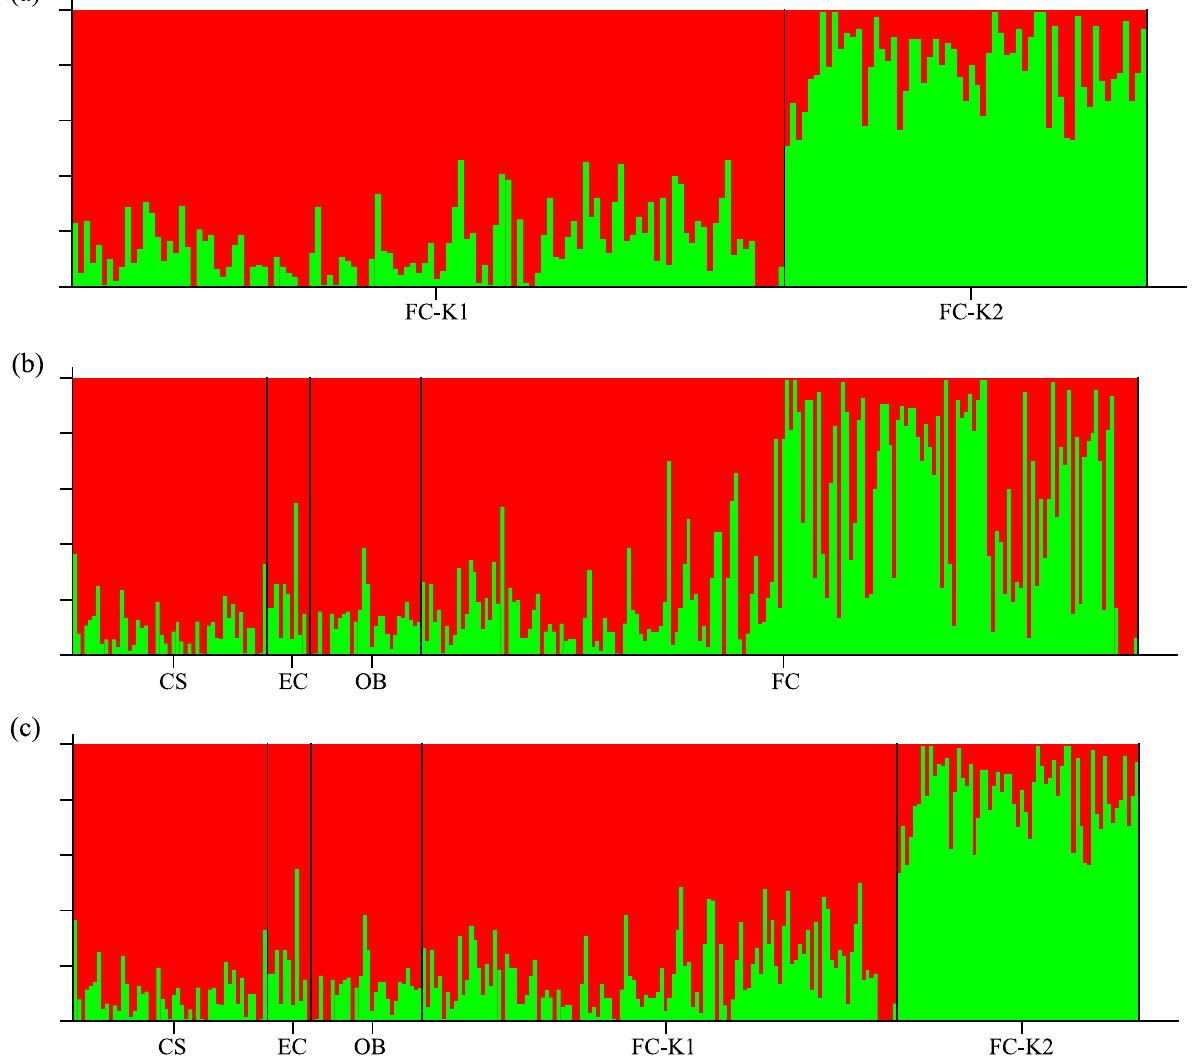
Figure 1. Structure outputs of Rhizophora mangle stands in Honduras. (a) Four principal sampling sites, CS Cuero y Salado, EC Elijah canal, OB Oyster bed lagoon, and FC Fort cay; (b) 400 m 2 parcel of forest at Fort Cay; and (c) Fort Cay divided into two sites, FC-K1 and